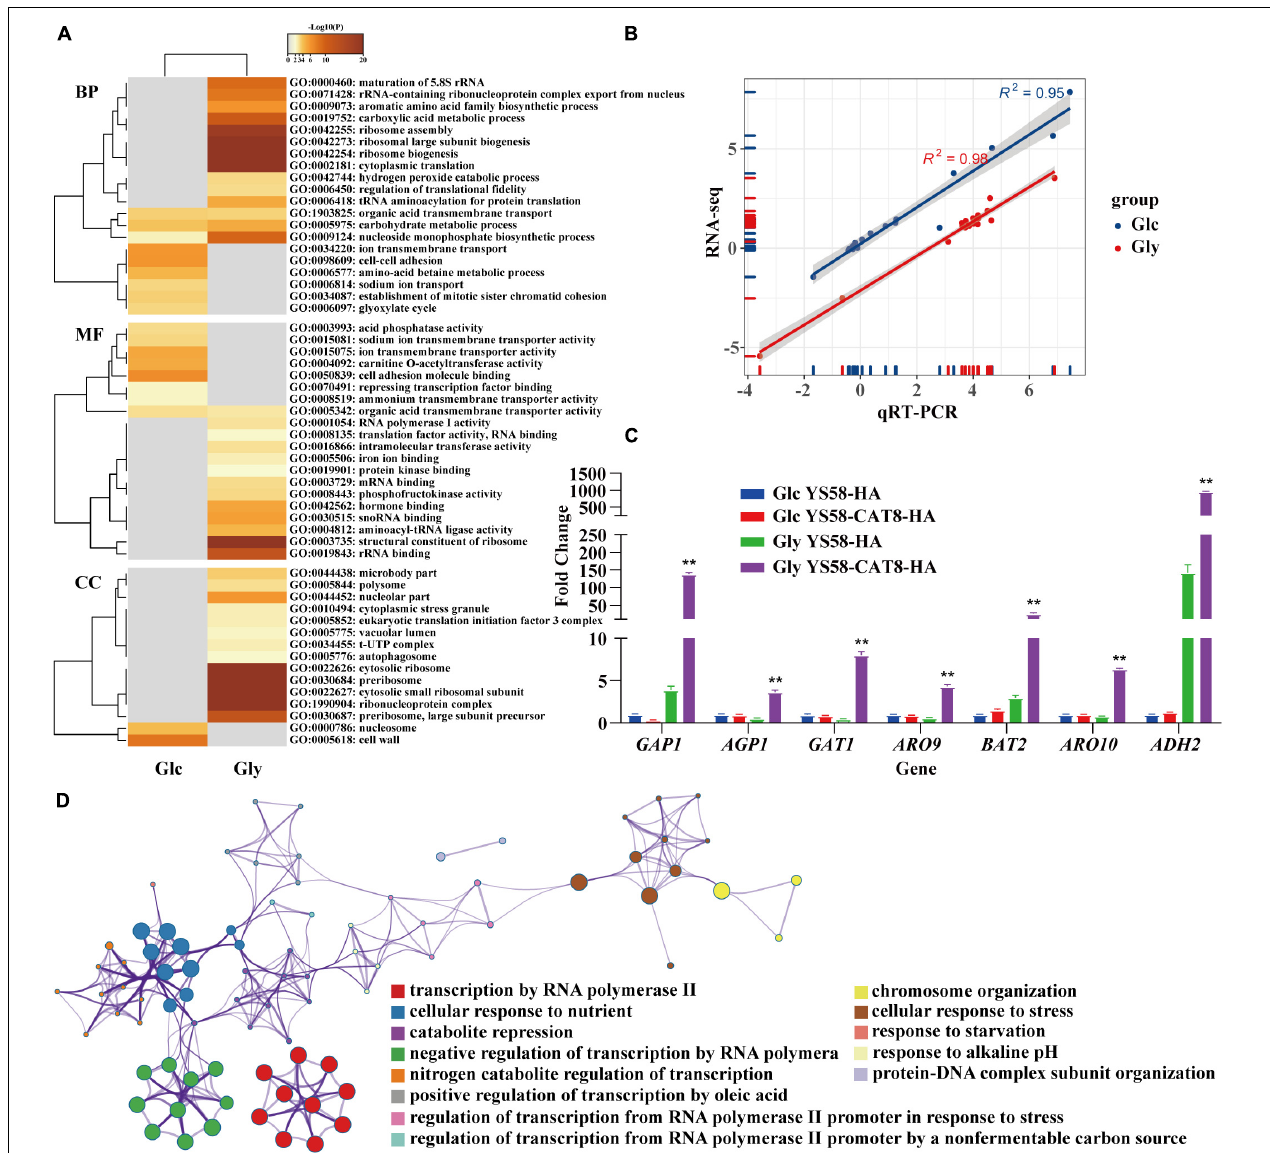
FIGURE 3 | RNA-seq analysis of yeast strain in response to external nutritional changes. (A) The list of differential genes in glucose (Glc) and glycerol (Gly) after overexpression of Cat8 was enriched by GO differential heat map of biological process (BP), molecular function (MF), and cellular component (CC). Heatmap showing the top enrichment clusters, one row per cluster, using a discrete color scale to represent statistical significance. Gray color indicates a lack of significance. (B) The correlation between RNA-seq and qRT-PCR results. (C) The transcriptional levels of genes related to fusel alcohols synthesis via Ehrlich pathway in RNA-seq data. (D) Metascape visualization of the interactome network formed by all 78 gene candidates from differential expression of transcription factors after Cat8 overexpression under Gly condition, where each node represented an enriched term and was colored by its cluster-ID. The strains used were YS58-HA